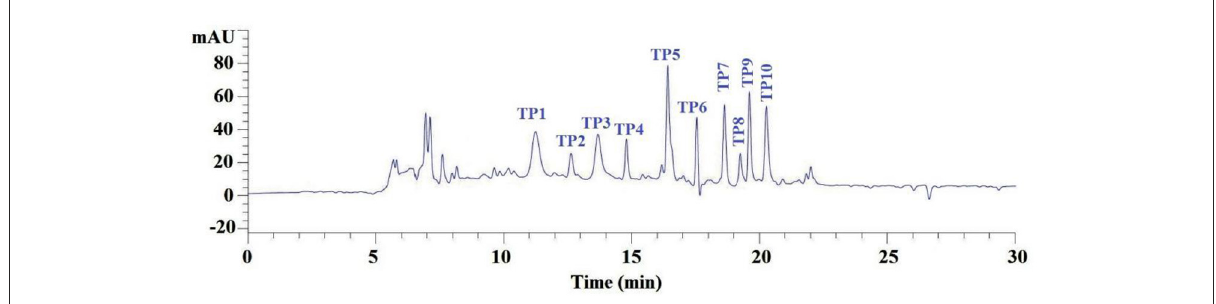
FIGURE4 Elution profile of subfraction GH-3 by RP-HPLC using a gradient of acetonitrile containing 0.06% trifluoroacetic acid at 214nm.